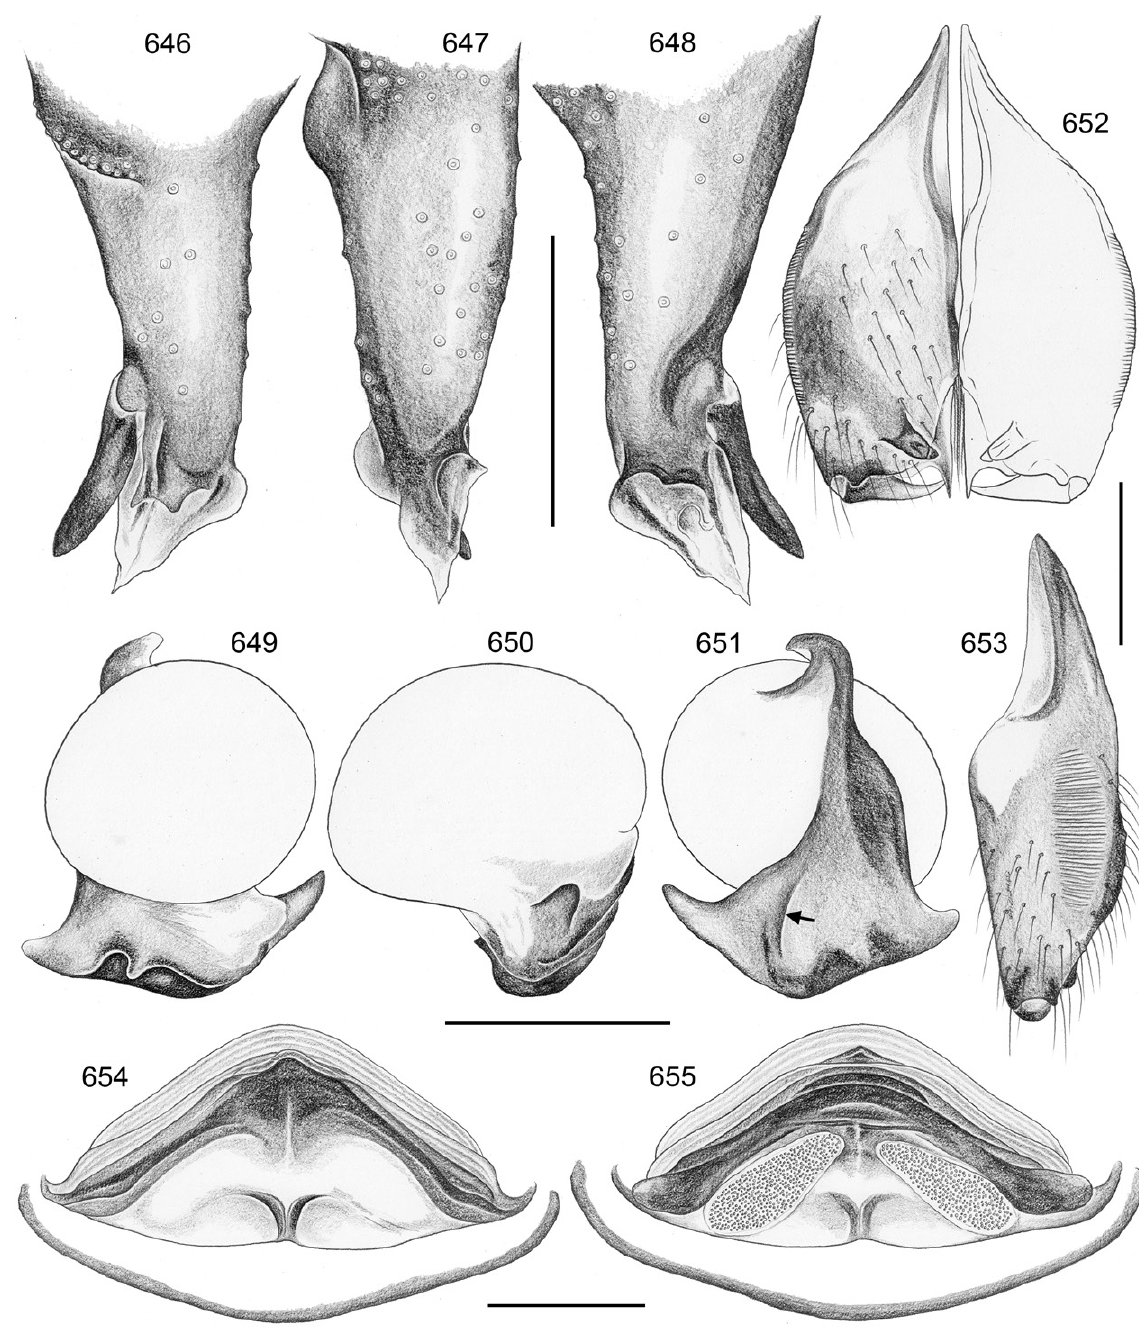
Figs 646–655. Crossopriza sanaa sp. nov.; holotype male from Yemen, Sana’a (646–651; NMNL ARA 15023), non-type male from near Sana’a (652–653; NMNL, unnumbered), and female from Sana’a (654–655; NMNL ARA 15215). 646–648 . Left procursus, prolateral, dorsal, and retrolateral views. 649–651 . Left genital bulb, prolateral, dorsal, and retrolateral views; arrow: retrolateral ridge. 652– 653 . Male chelicerae, frontal and lateral views. 654–655 . Cleared female genitalia, ventral and dorsal views. Scale bars = 0.3